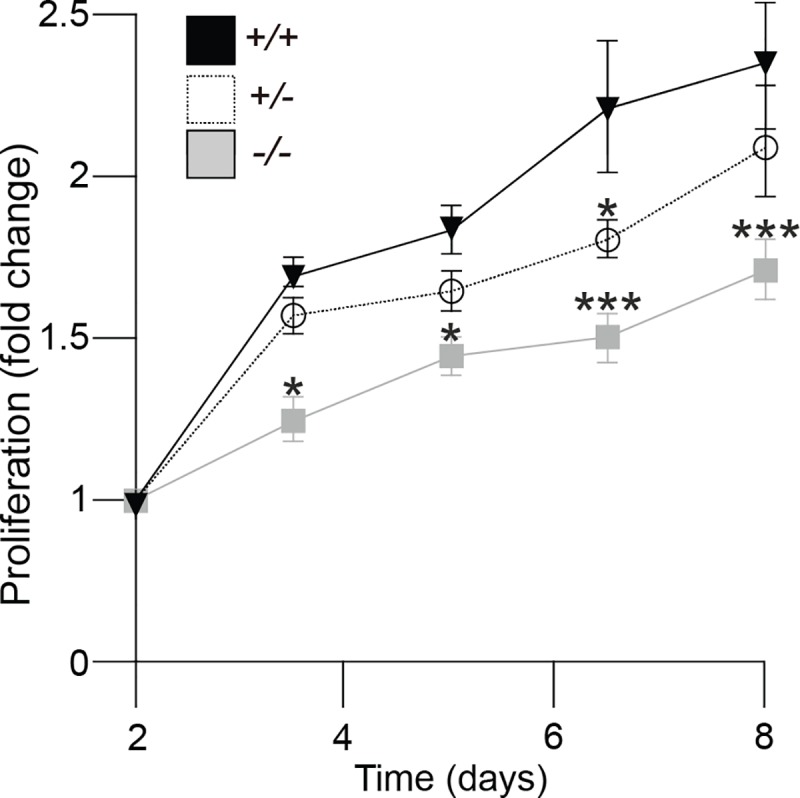
PIK3C2A deficiency causes delayed proliferation rates in patient-derived fibroblasts.Proliferation curve of primary fibroblasts isolated from PIK3C2A WT (+/+), heterozygous (+/-), and homozygous (-/-) individuals. Values are reported as the mean ± SEM from 3 independent experiments. * indicates p < 0.05, *** indicates p < 0.0001.